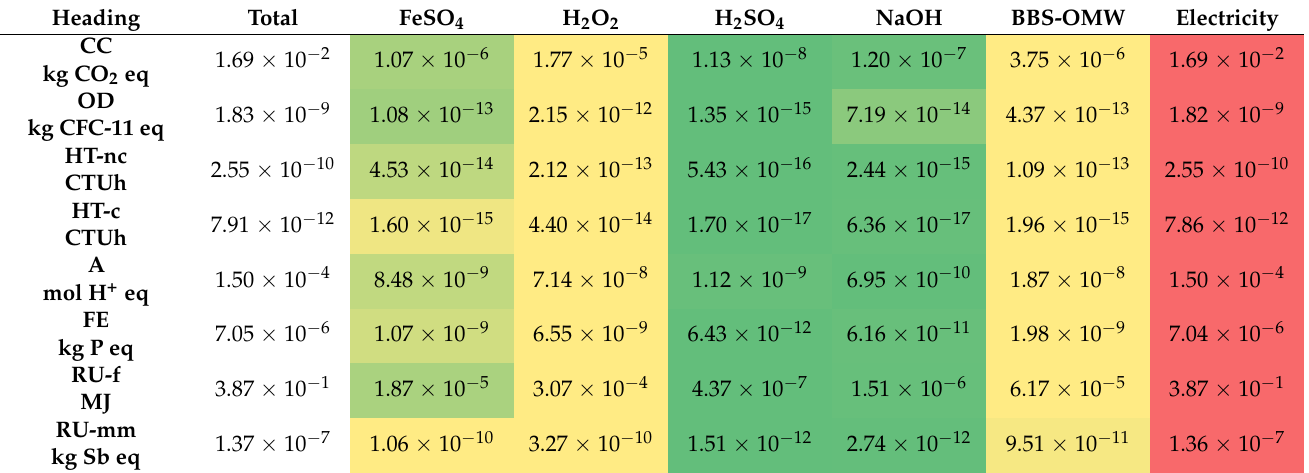
Table 8. LCIA results for the photo Fenton process, at laboratory level: treatment of 250 mL of